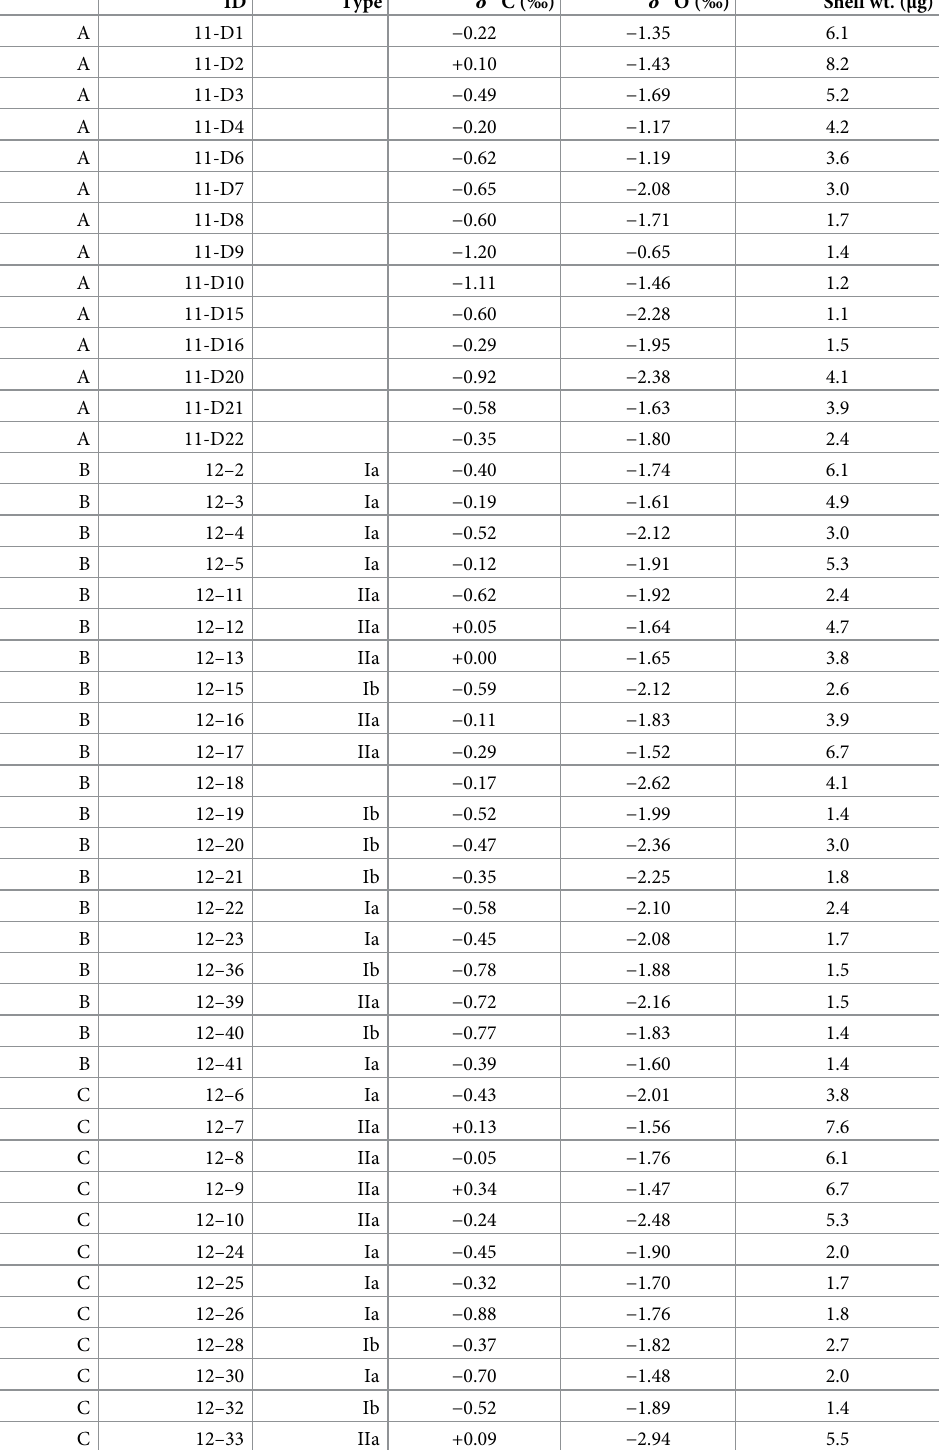
Table 2. Results for genetic type, δ 13 C and δ 18 O values, and shell weight of the planktic foraminifer Globigeri- noides ruber from stable isotope